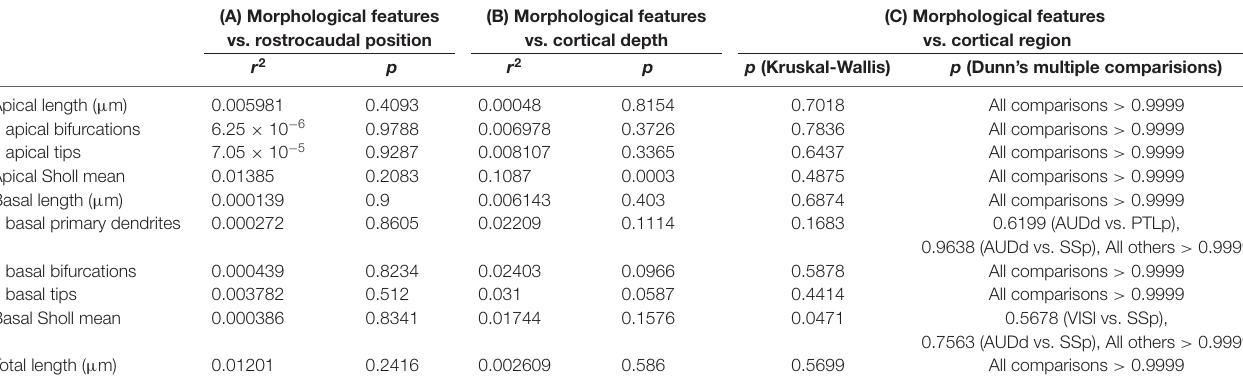
TABLE 1 | Statistical relationships between dendritic morphological features of supragranular neurons and rostrocaudal position, cortical depth and cortical region. (A) Morphological features (B) Morphological features (C) Morphological features vs. rostrocaudal position vs. cortical depth vs. cortical region r 2 p p (Kruskal-Wallis) p (Dunn’s multiple comparisions) Apical length ( µ m)